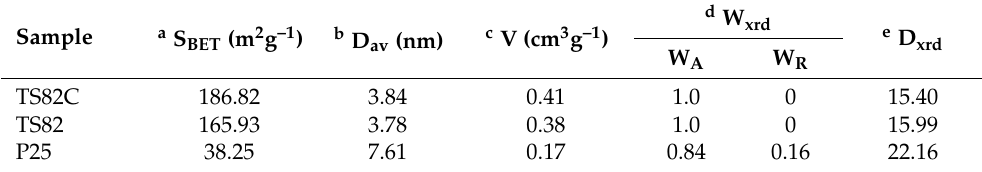
Figure 3. Nitrogen adsorption–desorption isotherm and BJH pore-size distribution plots (shown in inset) of TS82, TS82C nanocomposite calcined at 550 °C and P25 commercial (Evonik) TiO 2 powder. Table 1. BET surface area parameters of the respective samples.